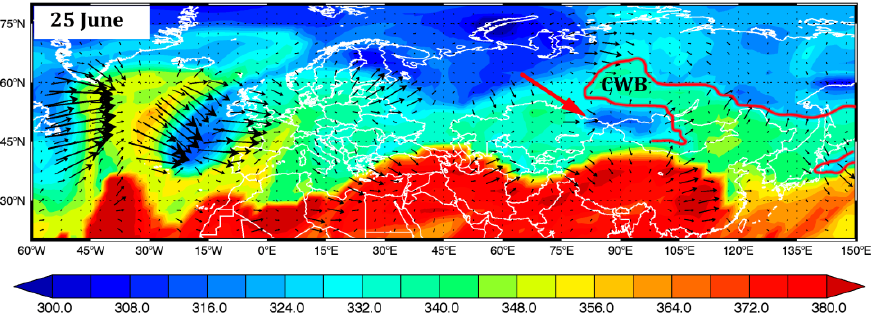
Figure 4. Circulation pattern (WAF—black arrows, m 2 /s − 2 and PV- Θ —fill, K) on 25 June (2nd period). Here and below the red arrow show the position of cold PV- Θ advection toward Siberia, the red curve demonstrates the horizontal scheme of RWB. Era-Interim data.